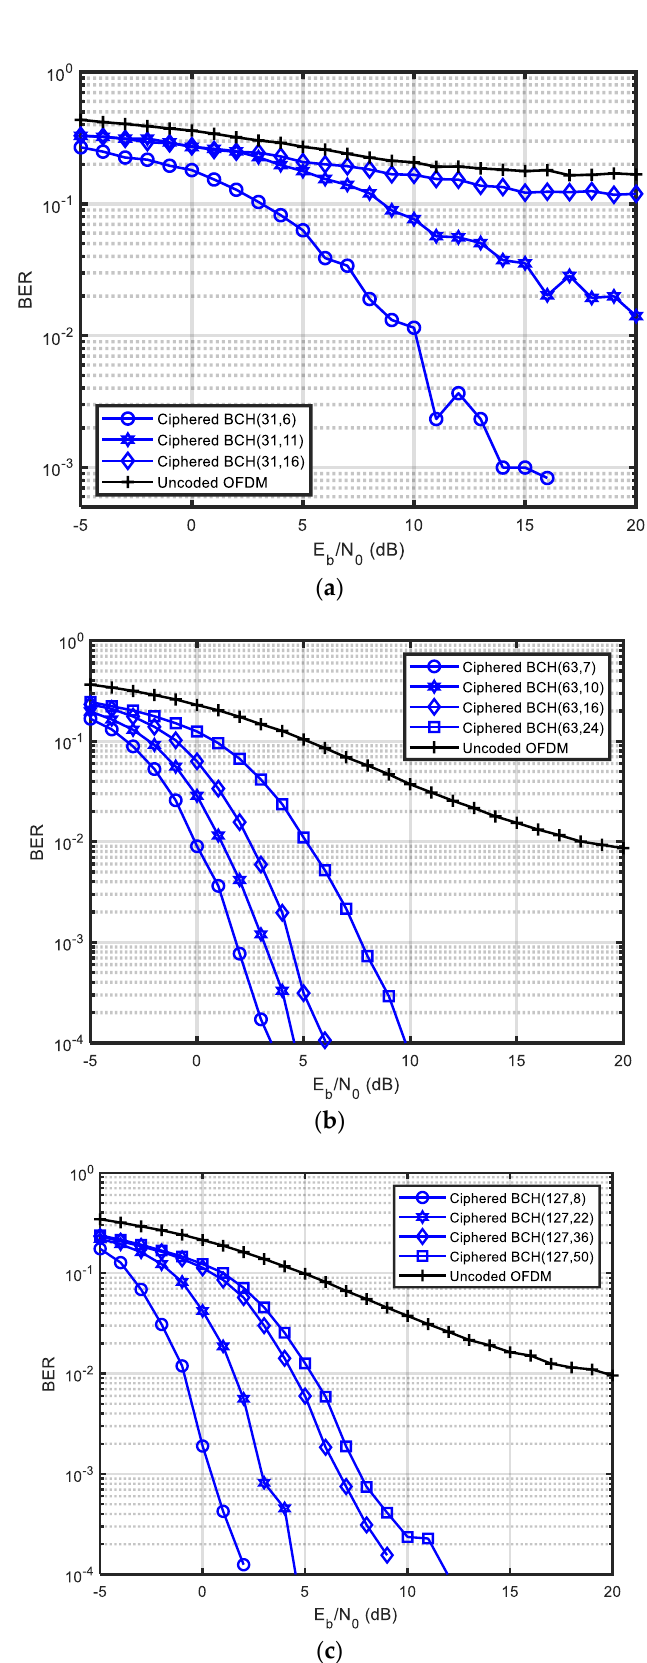
Figure 11. BER performance of C-BCH (31,𝑘) , C-BCH (63,𝑘) and C-BCH (127,𝑘) . (a) explanation, (b) explanation and (c) explanation.